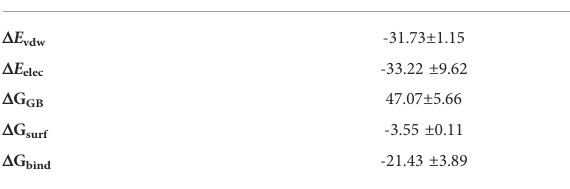
TABLE 3 The prediction of binding free energies and energy components by MM/GBSA.